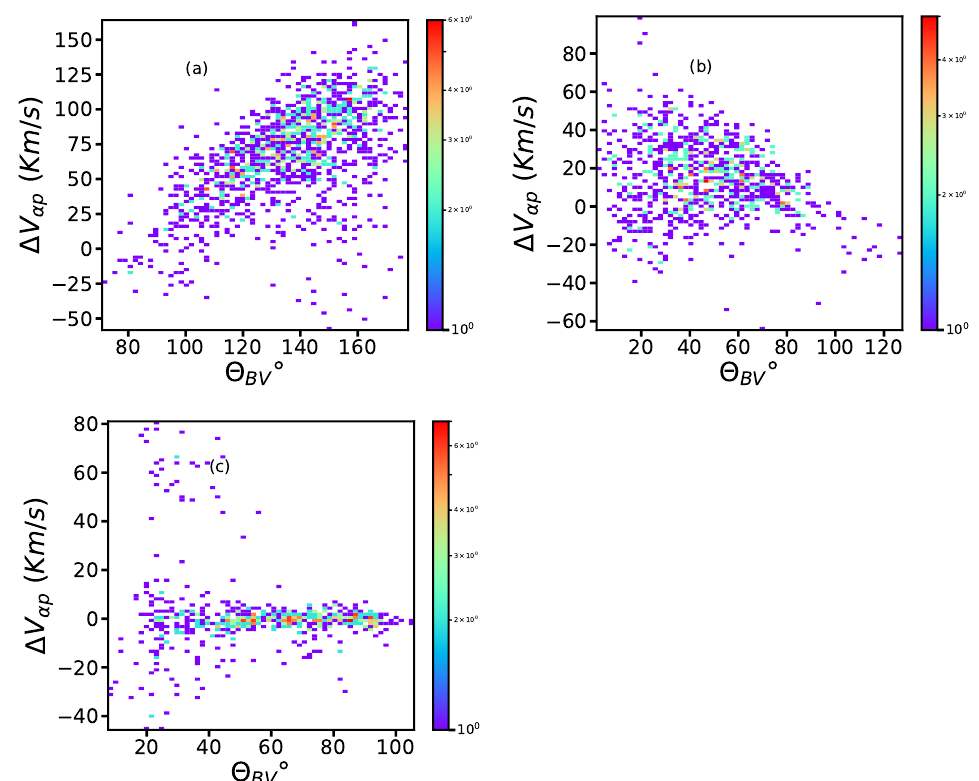
Figure 6. 2D histogram plot of alpha proton drift speed as a function of θ BV for the intervals around 0.3 au using the HELIOS 1 and 2 data. ( a ): fast wind interval from HELIOS 2 on 17 April 1976; ( b ): slow Alfvénic wind interval from HELIOS 1 on 23 March 1975; ( c ): slow non-Alfvénic wind interval from HELIOS 1 on 19 March 1975. The color bar represents the number of